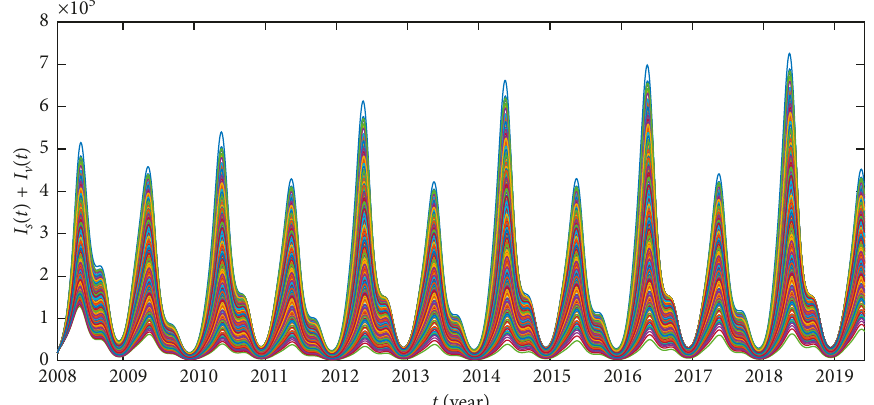
Figure 11: Multigroup numerically symptomatic infectious sample data I i , i � 1 , 2 , ... ,n ( n � 400) from system (1). θ i , i � 1 , 2 , .. . ,n ( n � 400) is generated by Latin hypercube sampling. The values of other parameters and the initial conditions are the same as in Figure 3.